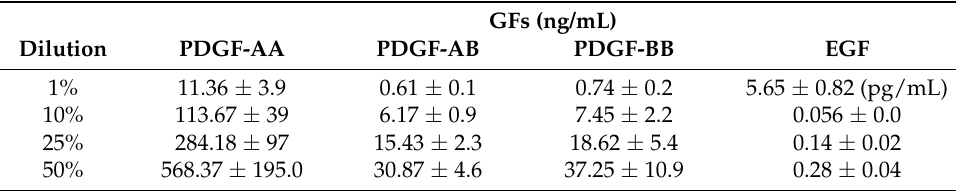
Table 3. PRP dilution in the culture medium, and corresponding GFs concentration, used to treat HOB-01-C1 cells. Data are expressed as percentage volume in the culture medium for PRP dilution and mean ± SD for GFs